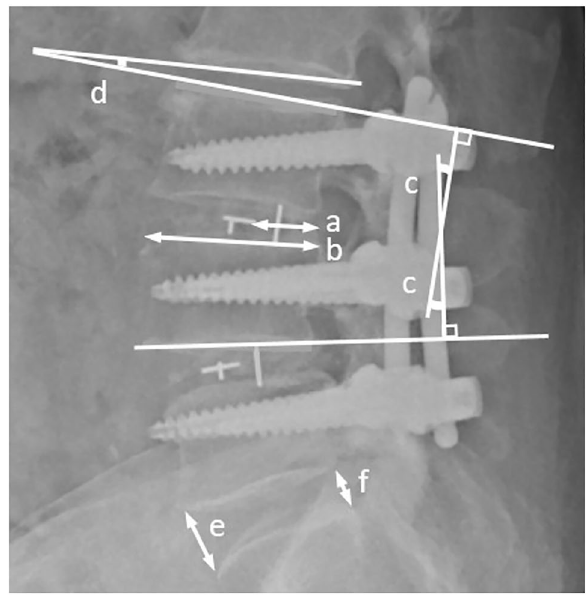
Figure 2. (1) The central point ratio (CPR) is the ratio of the distance between the midpoint of the cage and the posterior edge of the endplate (a); divided by the length of the superior endplate of the inferior vertebra (b). CPR = a/b × 100%. (2) Segmental lordosis angle (c) was measured at two lines parallel to the superior endplate of the cephalic surgical vertebra and the inferior end plate of the caudal surgical vertebra of the index level. (3) Disc height. Two vertical lines (e) and (f) are set at the anterior and posterior edge of the disc space, and the average of e and f was defined as the disc height. (4) Disc angle. Two lines parallel to the inferior endplate of the superior vertebra, intersect with the superior end plate of the inferior vertebra of disc space to form an angle. The angle (d) was defined as the disc